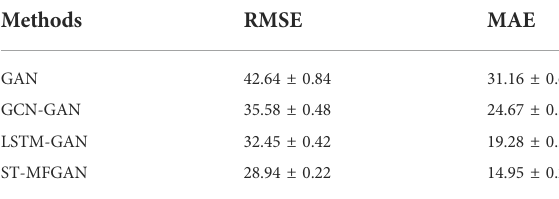
TABLE2TheRMSEandMAEoftheablationexperimentsinthetestset.